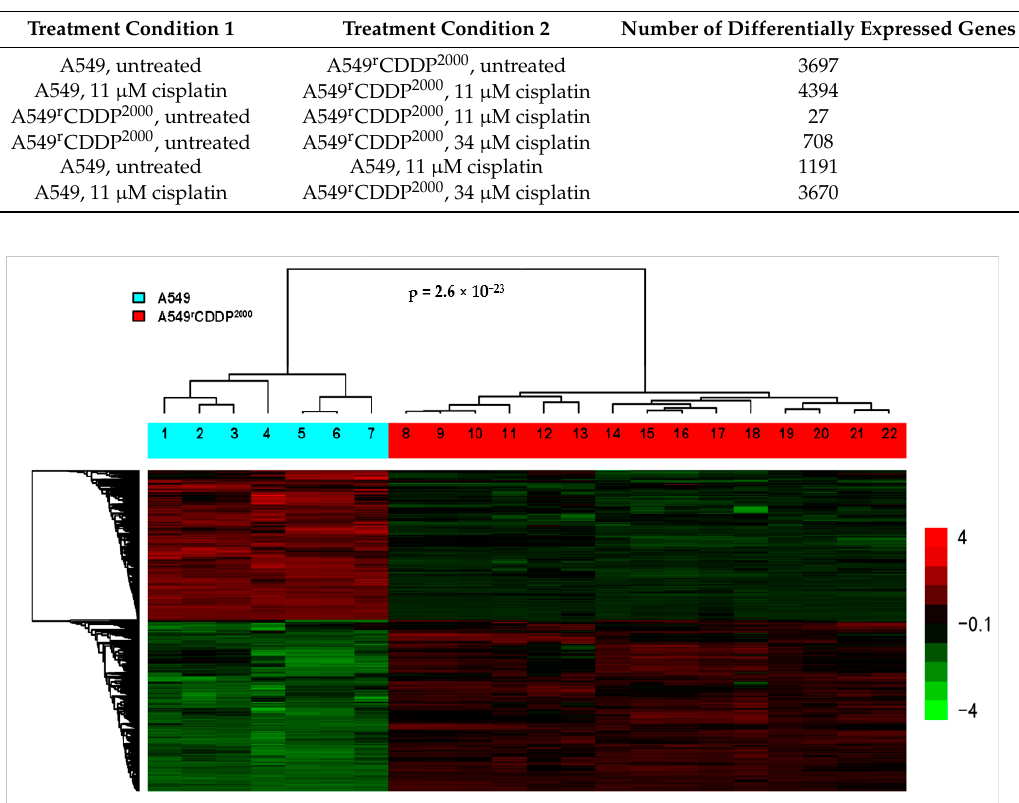
Figure 2. Heat map of the whole transcriptome, regulated genes with fold change cut-off at 2.0 and a false discovery rate of 5% of all replicates in sensitive and resistant cells. Numbers above lanes indicate: 1, 2, 3, 4: A549, untreated; 5, 6, 7: A549, treated with 11 µ M cisplatin; 8, 9, 14, 15, 16: A549 r CDDP 2000 , untreated; 10, 11, 17, 18, 19: A549 r CDDP 2000 , treated with 11 µ M cisplatin; 12, 13, 20, 21, 22: A549 r CDDP 2000 , treated with 34 µ M cisplatin. The p -value (2.6 × 10 − 23 ) corresponds